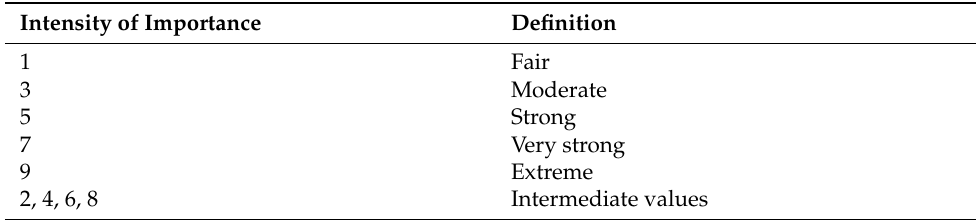
Table 1. The scales of pairwise comparison